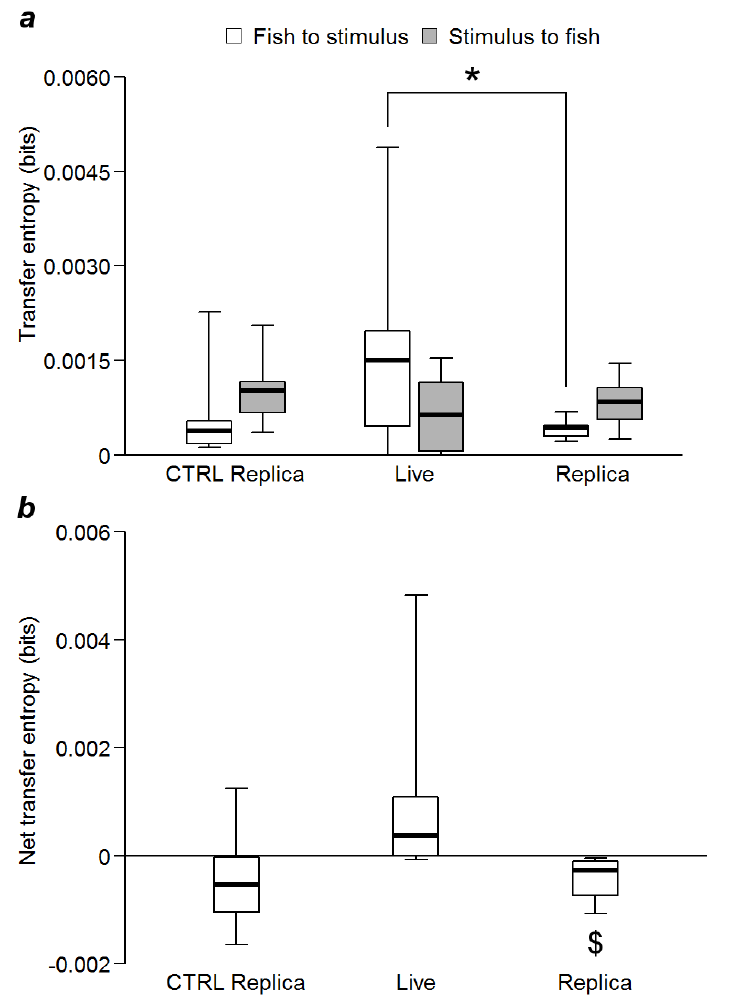
Figure 13 . Transfer entropy for experiments on the interaction between live fish and fear-evoking stimuli. Experiments refer to three conditions, in which we used as stimulus a live red tiger oscar (Live), a replica of the predator (Replica), and a simple moving rod (CTRL Replica). The bottom and top of each box are the first and third quartiles, the band inside the box is the median, and whiskers identify the entire distribution of the data. (a) Transfer entropy from zebrafish to the stimulus (white bars) and from stimulus to zebrafish (grey bars) and (b) net transfer entropy. The dollar symbol indicates a significant difference in comparison with zero. [Reproduced from (Neri et al.,